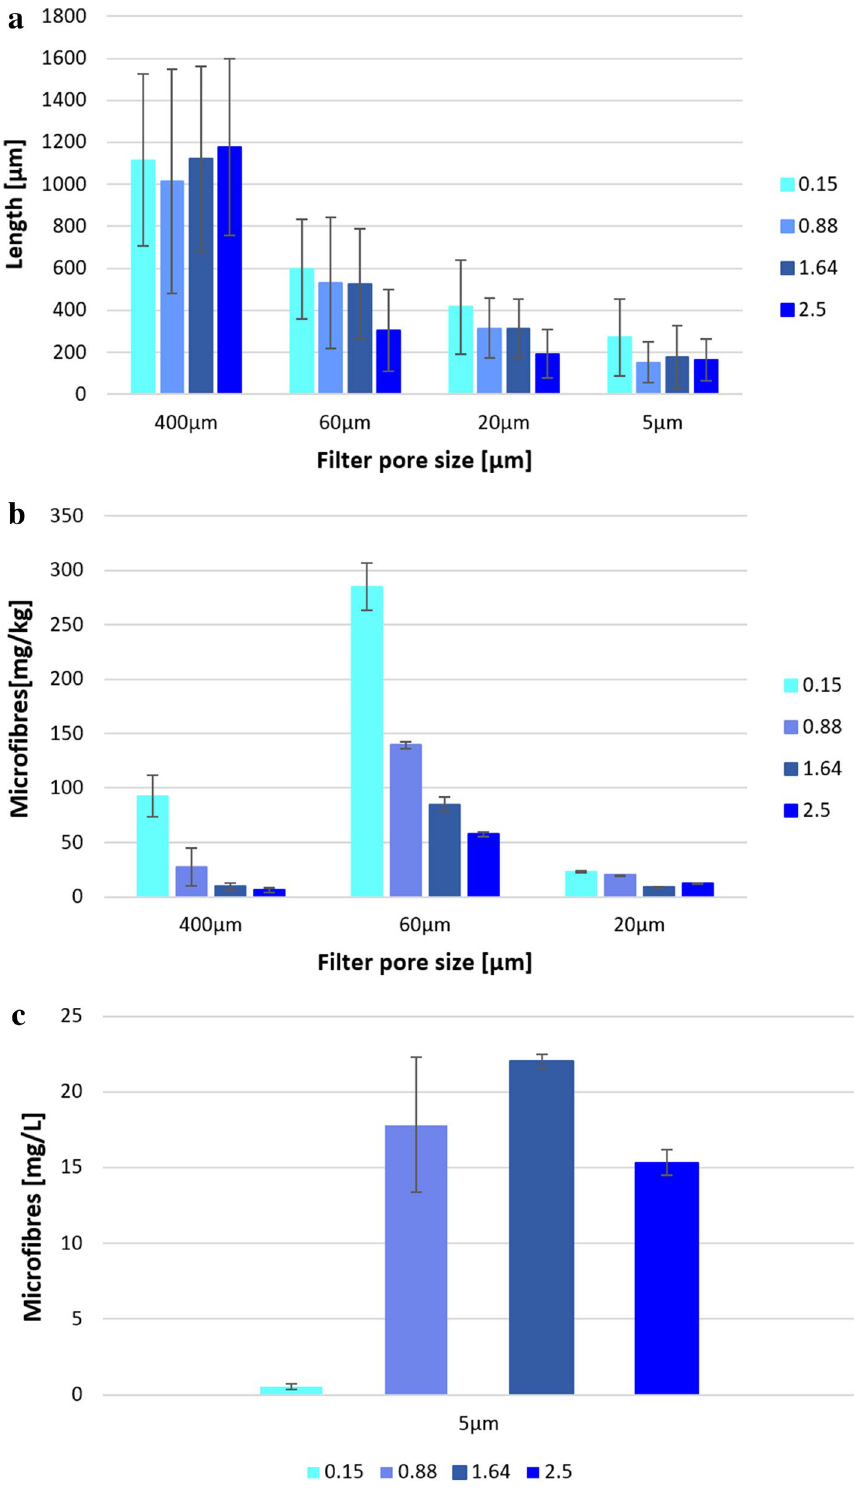
Figure 2. ( a ) Lengths of microfibres recovered on 400 μm, 60 μm,20 μm and 5 μm pore size filters (n = 30); ( b ) amount of microfibres recovered on 400 μm, 60 μm and 20 μm pore size filters (expressed in mg/kg ± SD, n = 2); ( c ) microfibres recovered on 5 μm pore size filters (expressed in mg/L ± SD, n =